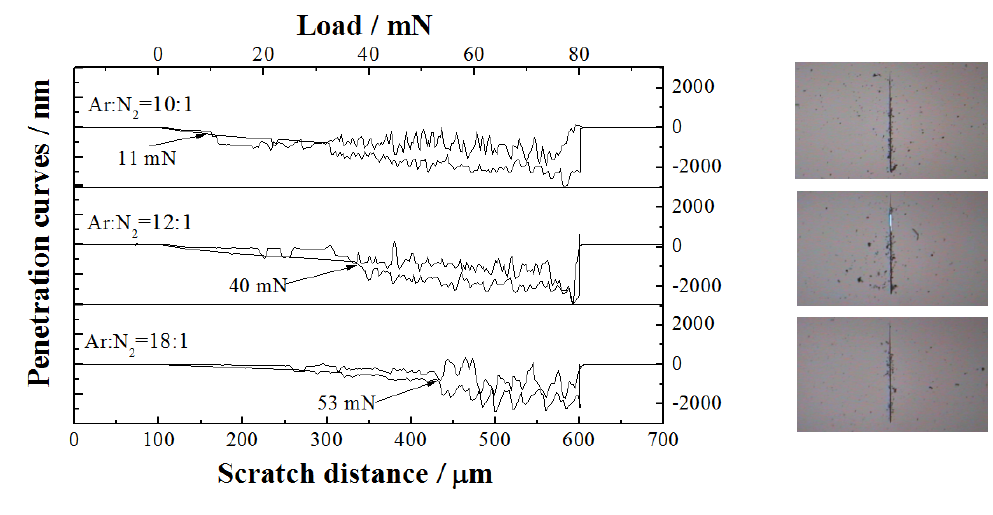
Figure 7 . Surface profiles of the scratch-scan on TiAlN/Al Ar/N 2